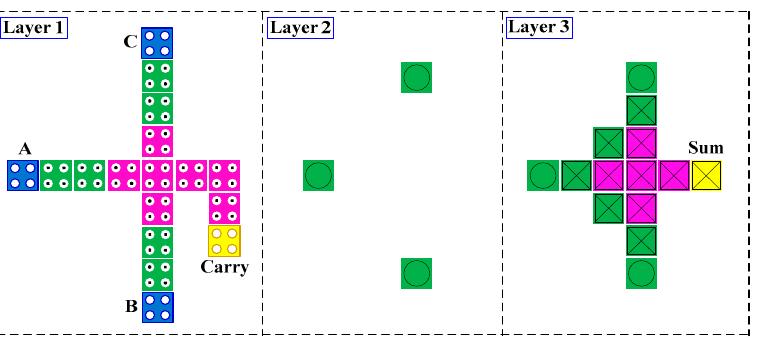
Figure 9. Block diagram of 4 × 4 Vedic multiplier.